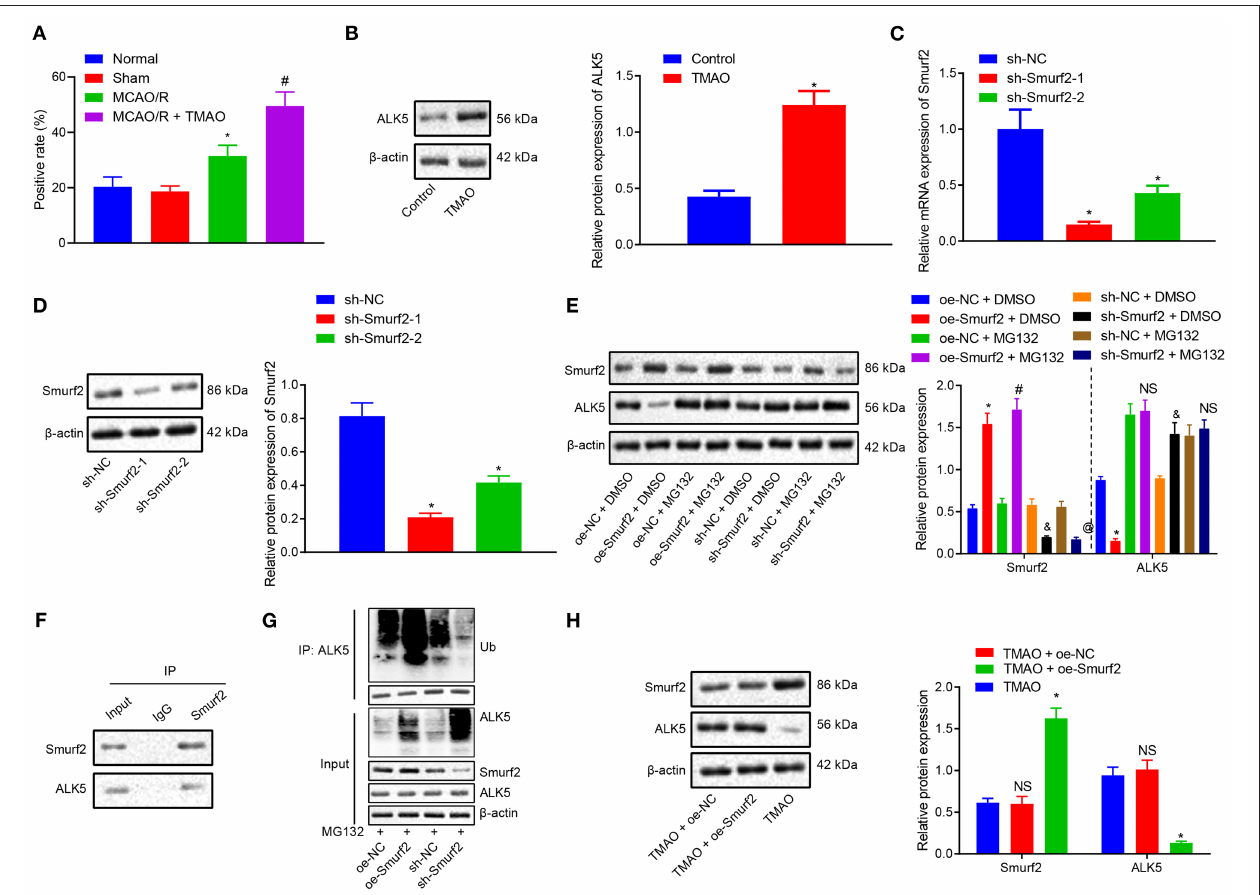
FIGURE 3 | TMAO promotes the expression of ALK5 via disruption of the Smuf2 ubiquitination function. (A) IHC results of ALK5 expression. (B) ALK5 expression determined by Western blotting in astrocytes. (C) Smurf2 expression determined by RT-qPCR in astrocytes. (D) Smurf2 expression determined by Western blotting in astrocytes. (E) ALK5 protein expression detected by Western blotting. (F) IP assay to detect the interaction between Smurf2 and ALK5 in astrocytes. (G) IP assay to detect the degree of ALK5 ubiquitination. (H) Protein expression of ALK5 in astrocytes assessed by Western blotting. * p < 0.05 compared with the control, sh-NC, oe-NC + DMSO or TMAO + oe-NC group. # p < 0.05 compared with the oe-NC + MG132 group. & p < 0.05 compared with the sh-NC + DMSO group. @ p < 0.05 compared with the sh-NC + MG132 group. NS indicates the comparison is not statistically significant. Unpaired t -test is adopted for data comparison between two groups. One-way ANOVA is employed for data comparison among multiple groups followed by Tukey’s post hoc